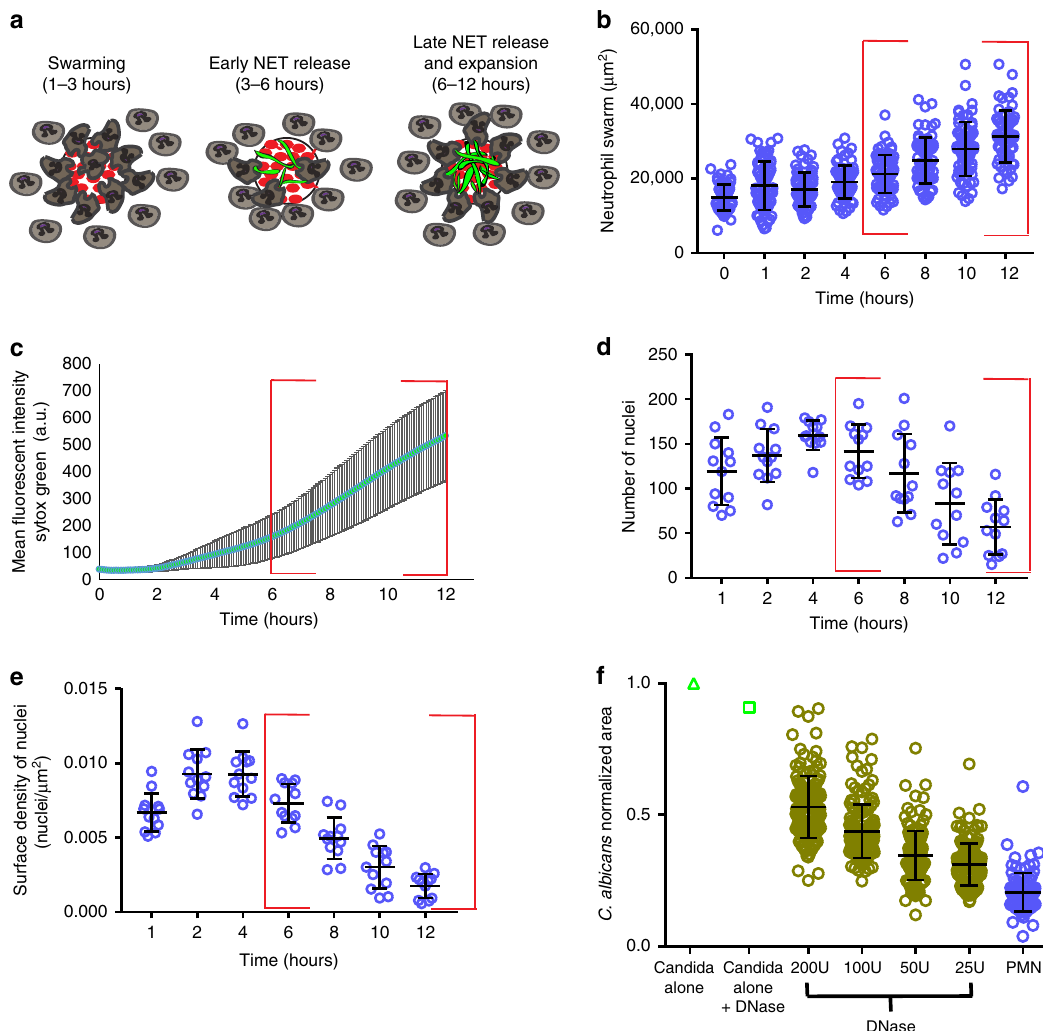
Fig. 3 Human neutrophils release NETs during swarming to C. albicans . Human neutrophils were incubated with C. albicans arrays with Sytox green included in the solution to visualize NET formation during swarming. A cartoon model is shown in ( a ), demonstrating the distinct phases of swarming and NET release. The area of the neutrophil swarms around C. albicans ( b ), the mean fl uorescent intensity of Sytox green staining in the swarm ( c ), the number of nuclei in the swarm ( d ) and the number of nuclei/ µ m 2 ( e ) were all quanti fi ed. A red box highlights the timeframe of NET formation and late phase swarm expansion ( b – e ). N = 68 swarms across three donors for except for the 12 hour timepoint, where N = 60 swarms across three donors ( b ). N = 44 swarms for ( c ). N = 12 swarms for d and e . The inclusion of DNase in the media during the swarming assay results in a dose dependent loss of control of C. albicans growth ( f ). Results are normalized to the growth of the C. albicans alone control. N = 144 swarms over 3 independent donors except for the control PMN group where N = 95 swarms over 3 donors. Error bars represent mean + / − standard